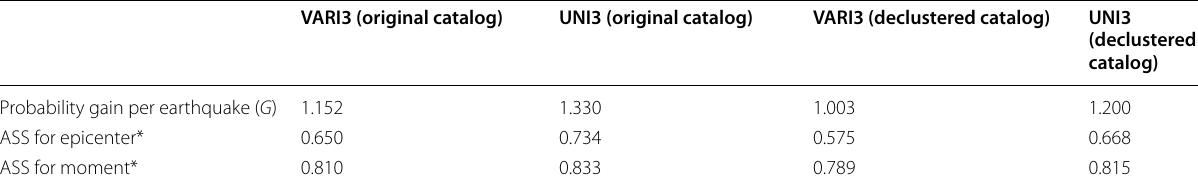
(declustered catalog)